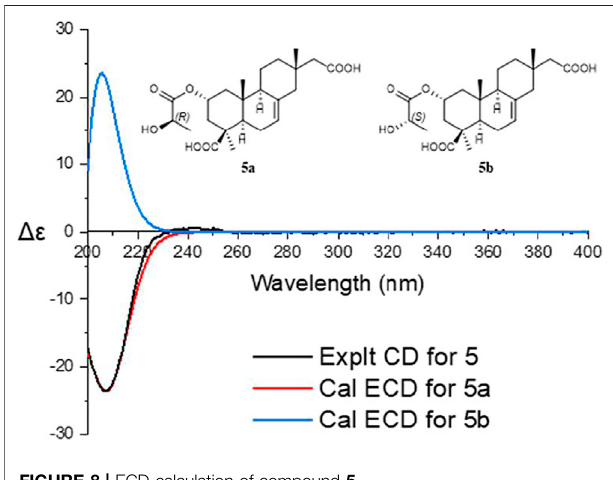
FIGURE 8 | ECD calculation of compound 5